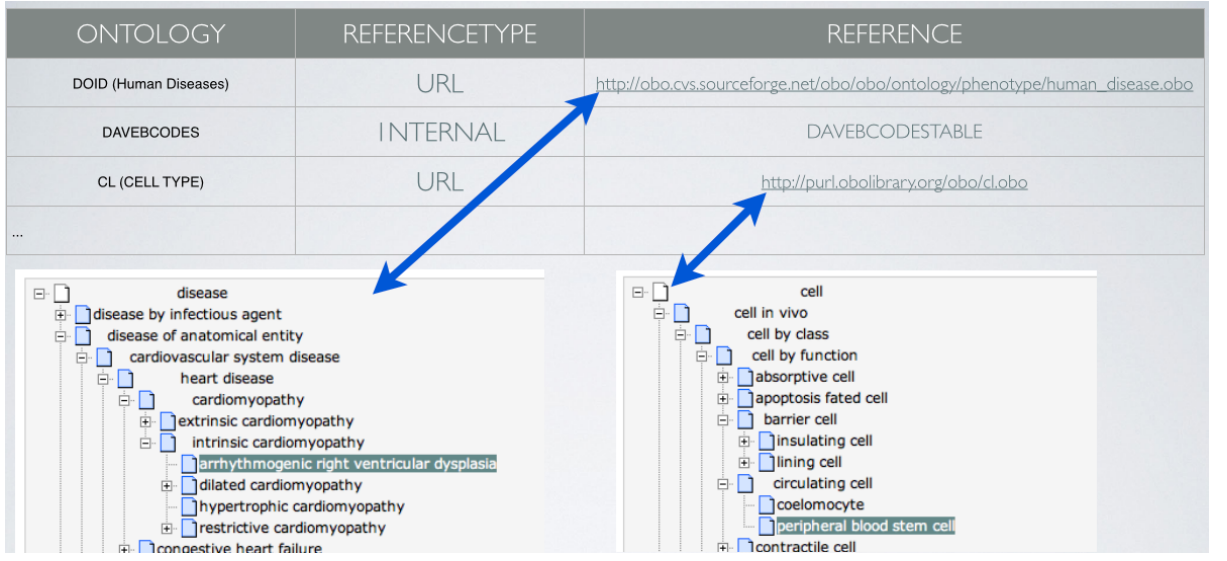
Figure 4. The daVEB Ontologies